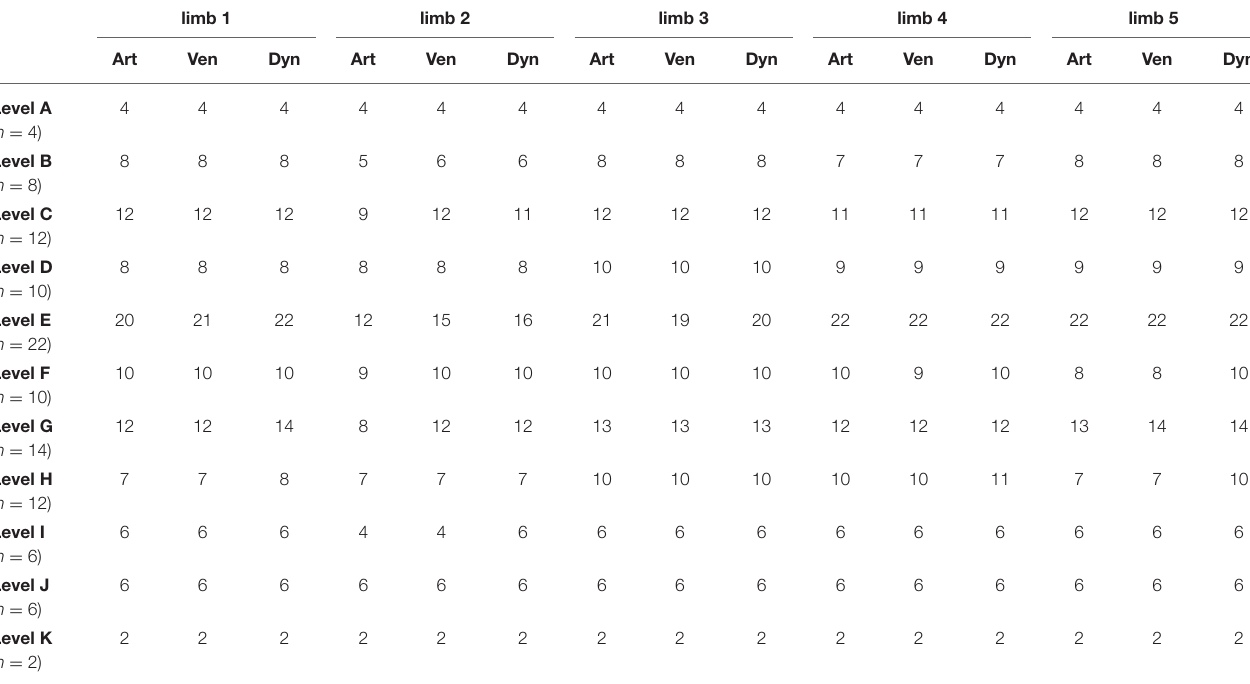
TABLE 1 | Comparison vascular visualization of different limbs perfused with lipophilic